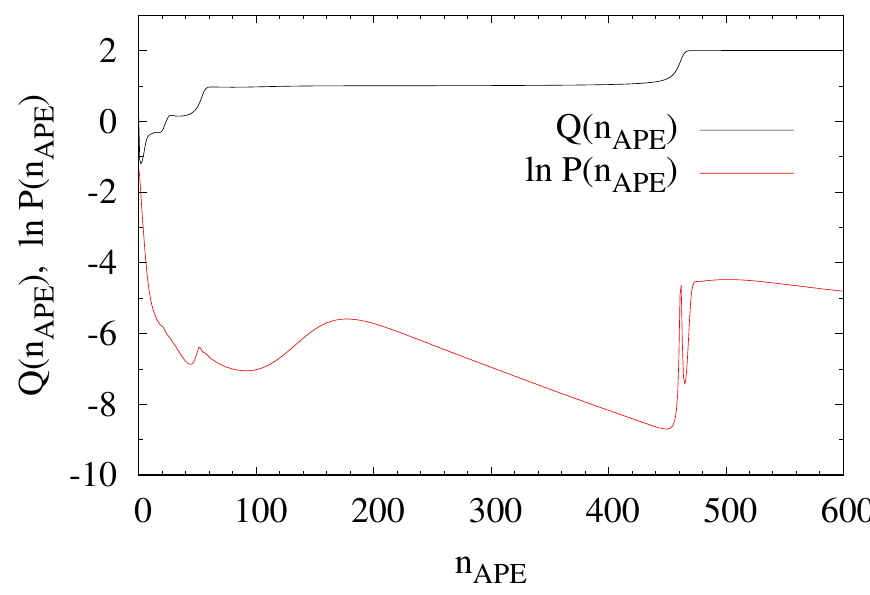
Figure 3 . An example of Q ( n APE ) and ln P ( n APE ) as a function of n APE at β = 1 . 850 .